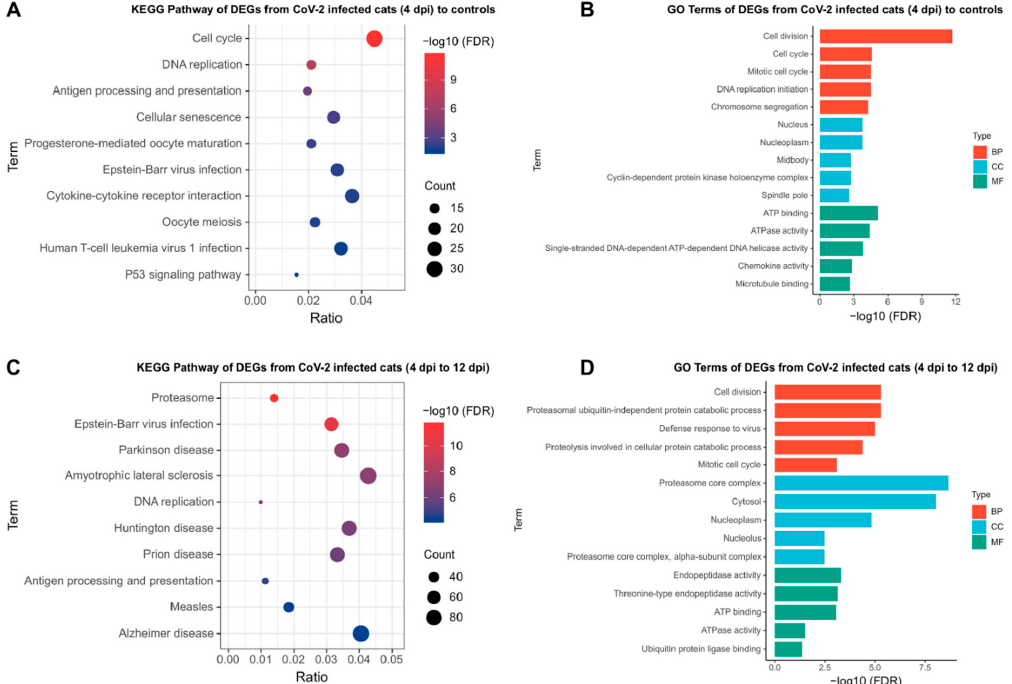
Figure 7. KEGG pathway and gene ontology (GO) terms enrichment in lung samples during SARS- CoV-2 infection. KEGG pathway and gene ontology (GO) terms enrichment based on DEGs in uninfected controls vs. 4 dpi ( A , B ) and 4 dpi vs. 12 dpi ( B , D ). KEGG Pathway analysis ( A , C ) with DEG’s denotes the ratio of the number of differentially expressed genes (x-axis) compared to the total genes in a particular pathway (y-axis). Gene ontology (GO) enrichment analysis ( B , D ) denotes the algorithm of adjusted p-values (FDR, x-axis) corresponding to specific GO pathways (y-axis).